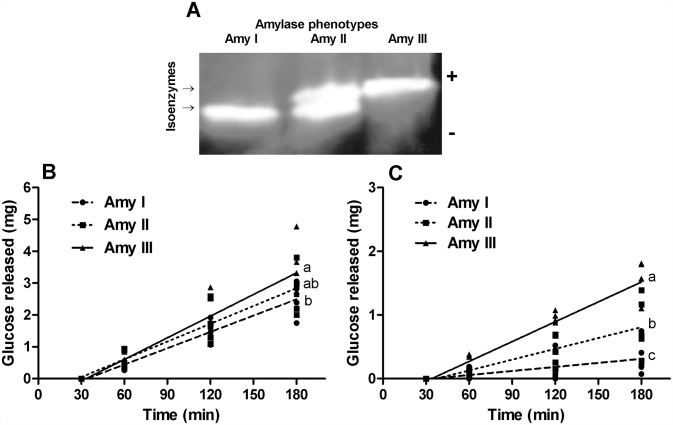
Alpha-amylase phenotypes in the lobster Panulirus argus differ in digestion efficiency.A) Alpha-amylase isoenzyme patterns (i.e., phenotypes) in lobster revealed by starch zymography. Lobsters with the isoenzyme of higher electrophoretic mobility are named phenotype Amy I, individuals with both isoenzymes are named phenotype Amy II, and lobsters with the isoenzyme of lower electrophoretic mobility are named phenotype Amy III. Graphs represent the kinetic of glucose released (cumulative values against time) from wheat flour (B) and maize starch (C) during in vitro digestion by crude digestive extracts of P. argus with the different α-amylase phenotypes. Letters to the right of regression lines indicate differences (P<0.05) among slopes.